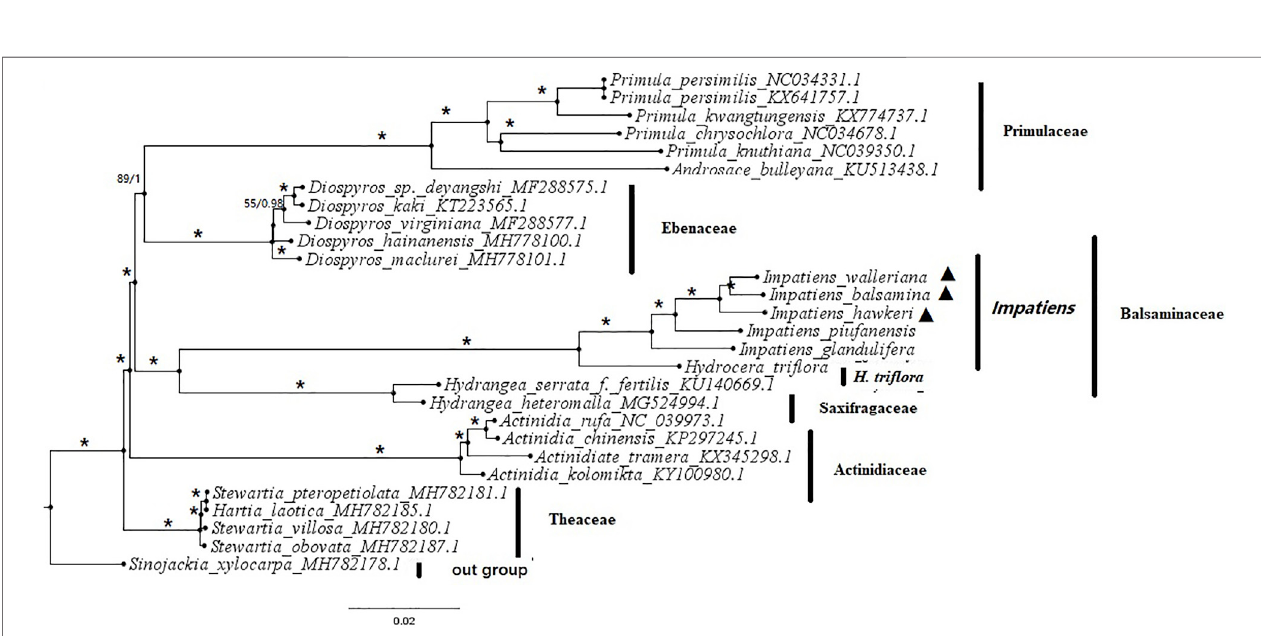
FIGURE8| Phylogenetictreebasedonwholechloroplastgenomesequencesfrom6 Balsaminaceae speciesand23otherspeciesusingmaximumlikelihood(ML) bootstraps and Bayesian posterior probabilities (PP). ML topology is shown with ML bootstrap support values/Bayesian PP given at each node. Asterisks indicate both of PP = 1 and LBS = 100%. Black triangles indicate the cp genomes of the three Impatiens species examined in this study.